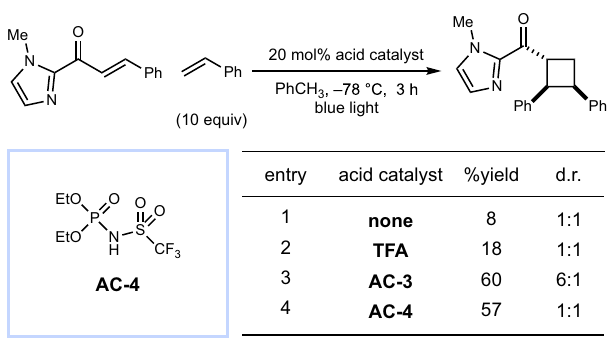
Fig. 6 Effect of structurally diverse Brønsted acids on the cycloaddition. Yields and diastereomer ratios determined by 1 H NMR